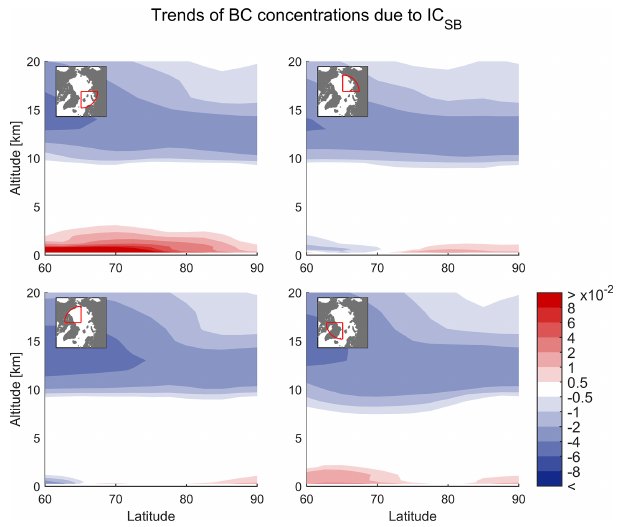
Figure 6. Winter (DJF) trends (1980–2005) of maximum like- lihood estimates of BC concentrations (ngkg − 1 yr − 1 ) associated with IC SB circulation pattern. BC concentrations at each model ver- tical level and latitudes above 60 ◦ N are averaged over 90 ◦ longi- tudes segments of the Arctic, indicated on the map on the left upper corner of each plot.